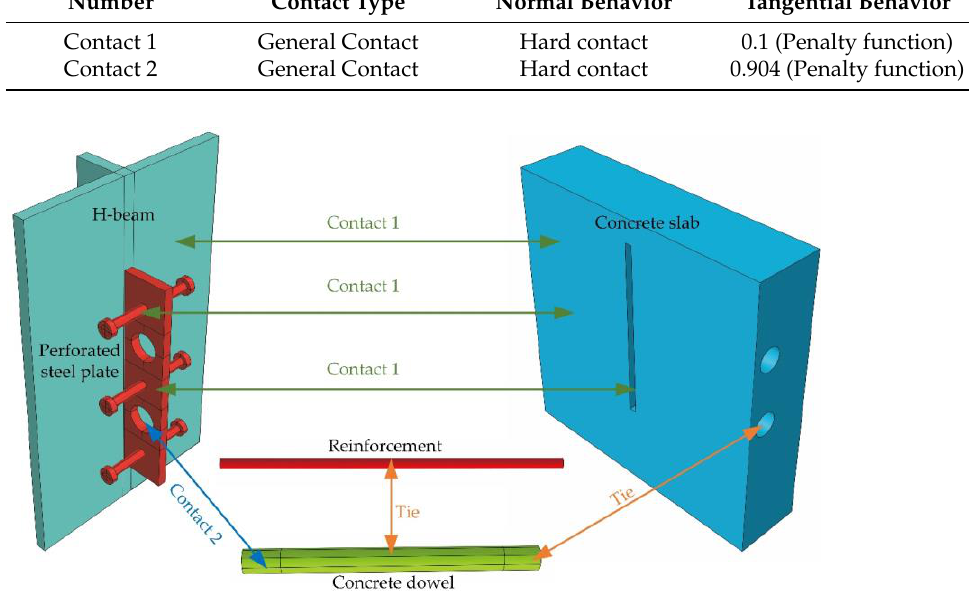
Figure 15. Interaction of components.